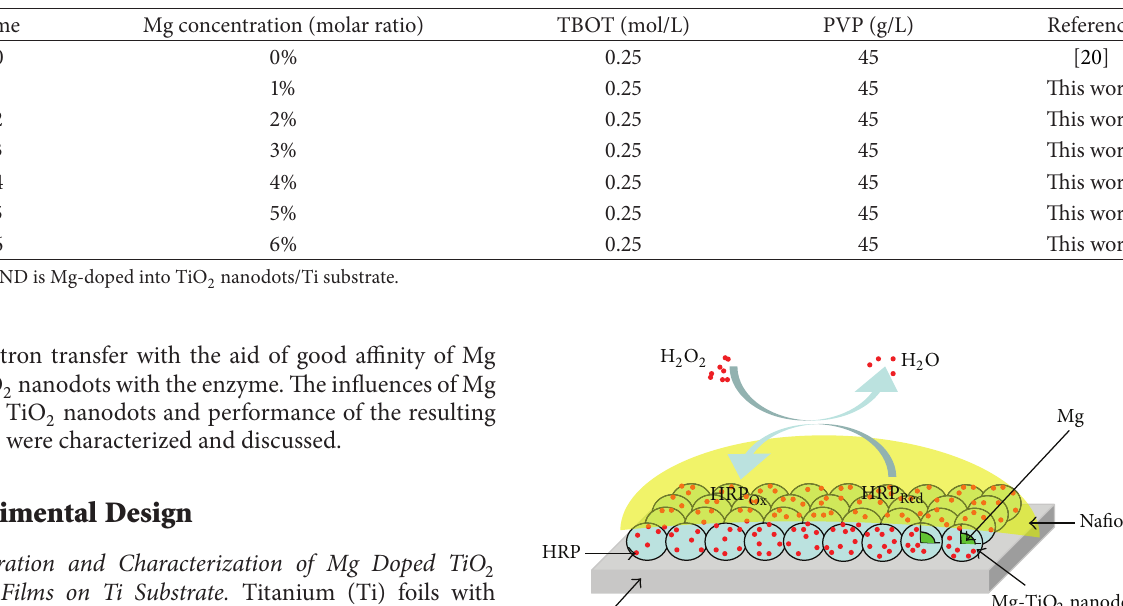
Table 1: Concentrations of Mg, TBOT, and PVP in the precursor sols for different TiO